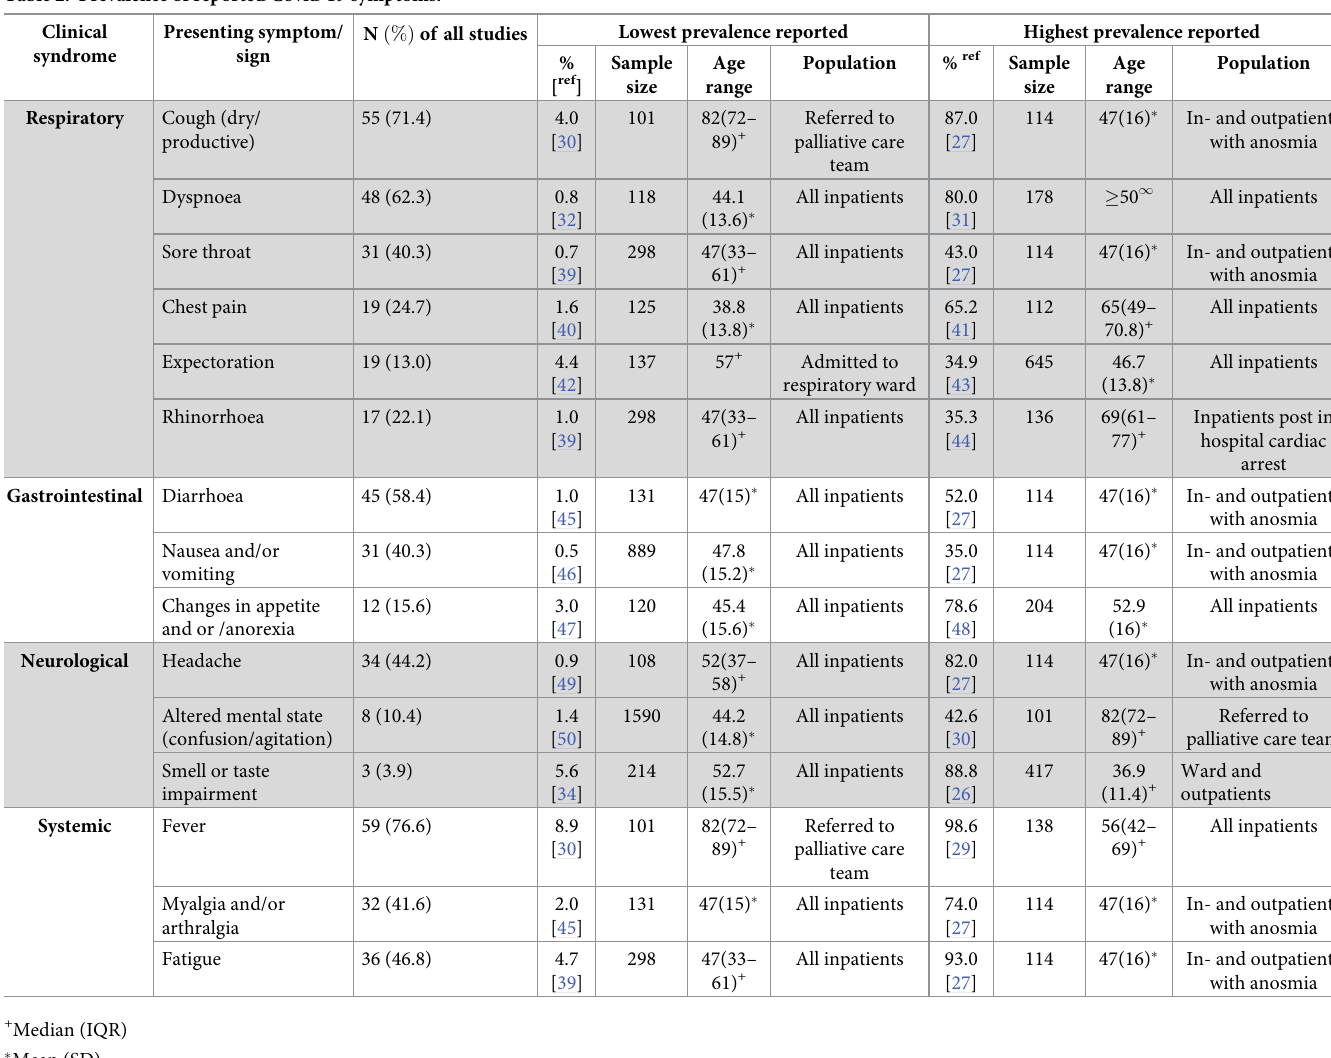
Table 2. Prevalence of reported Covid-19 symptoms. Clinical